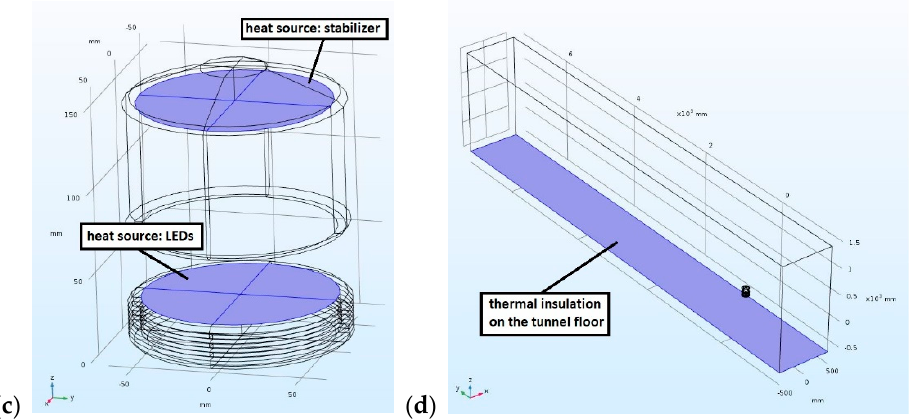
Figure 2. CAD drawing depicting the applied materials: ( a ) parts made of aluminum, ( b ) parts made of acrylic plastic, and the critical boundaries: ( c ) heat sources, ( d ) thermal insulation.